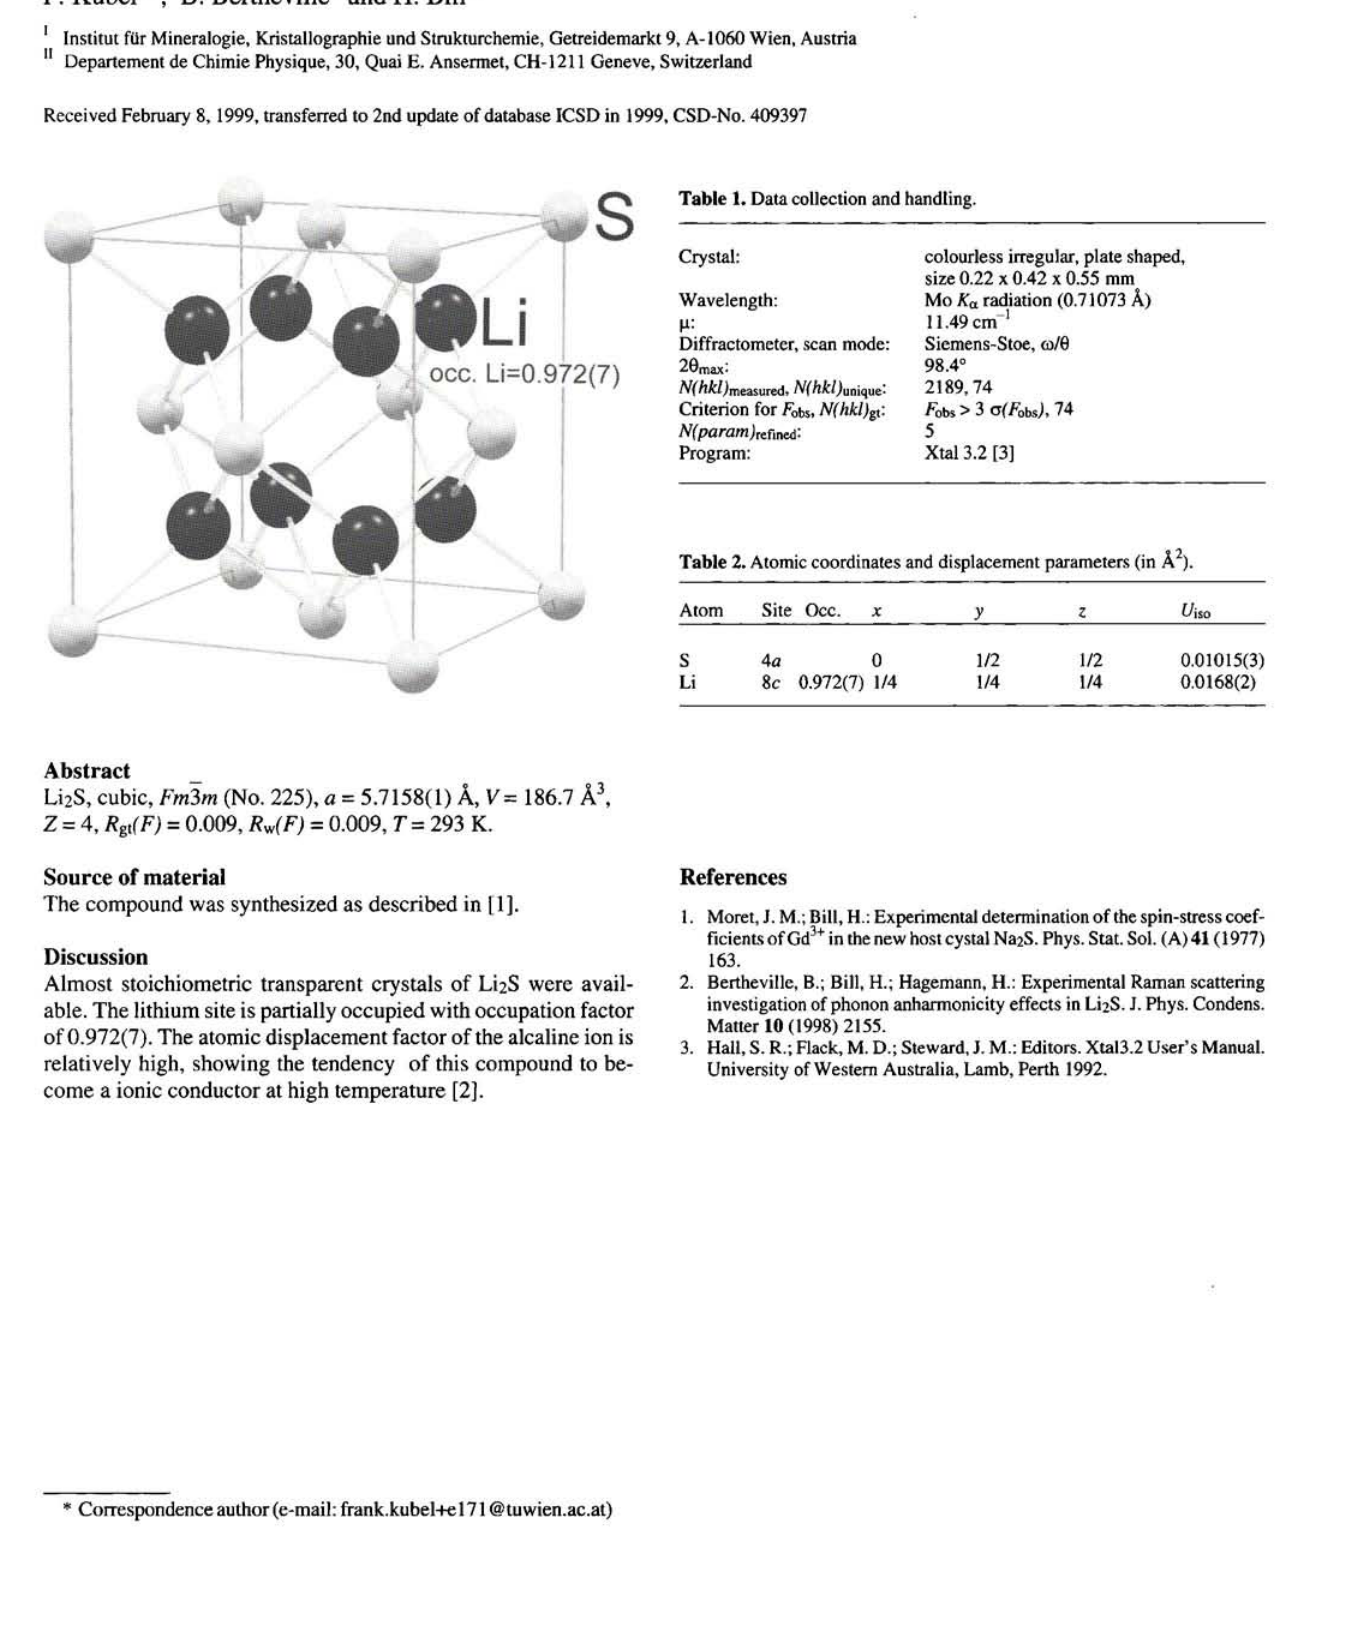
Table 1. Data collection and handling.